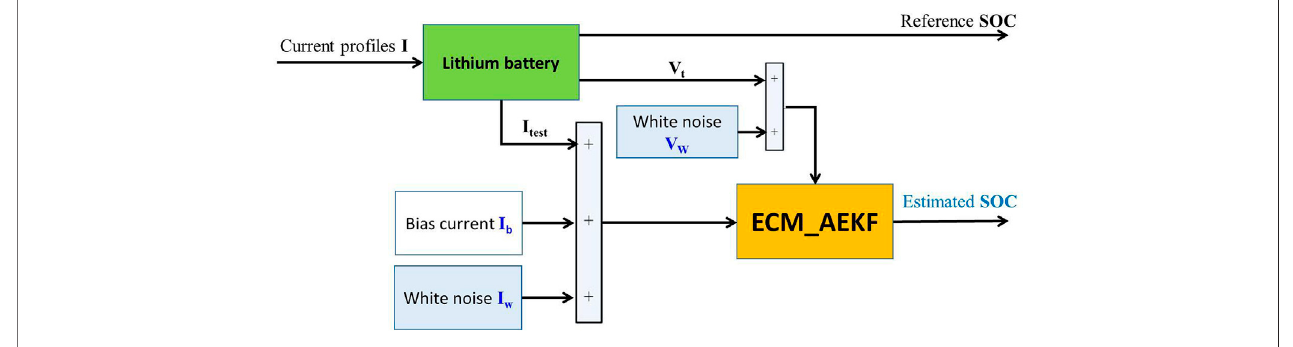
FIGURE 4 | SOC estimation strategy with sensors ’ noise